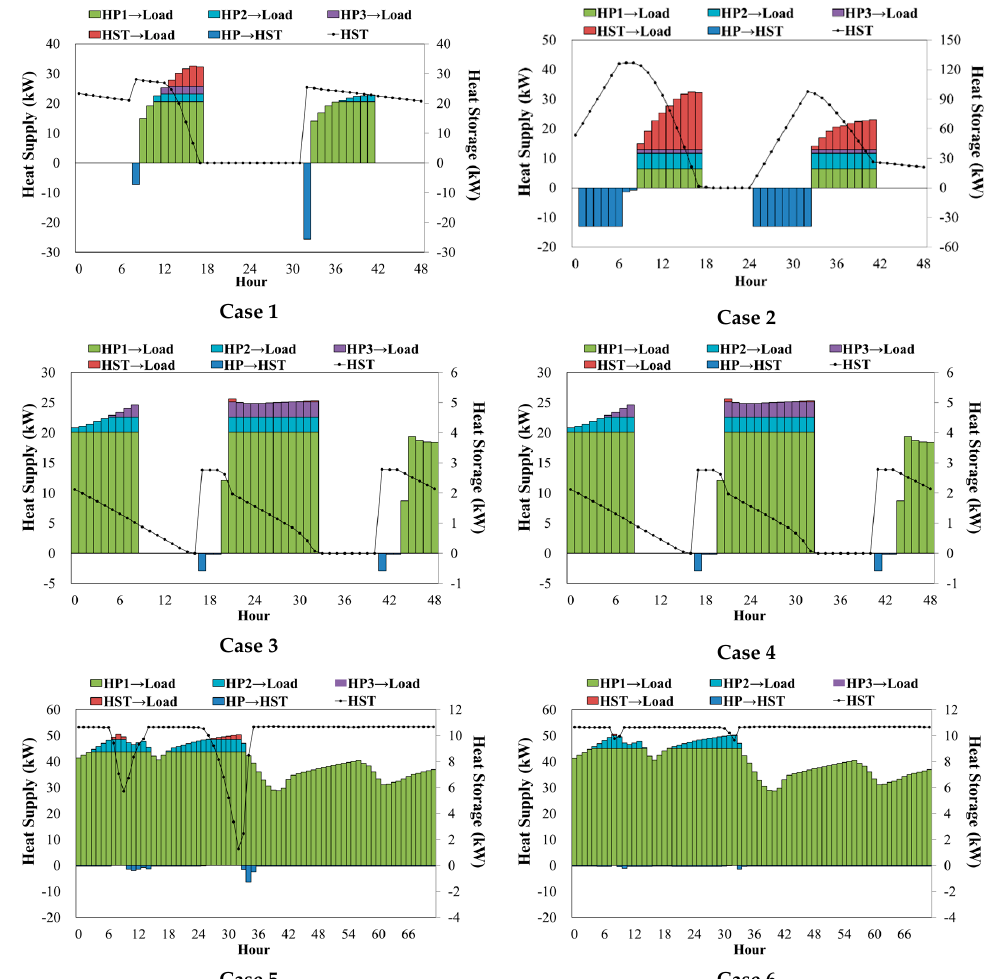
Figure 12. Operation planning of optimum solution.